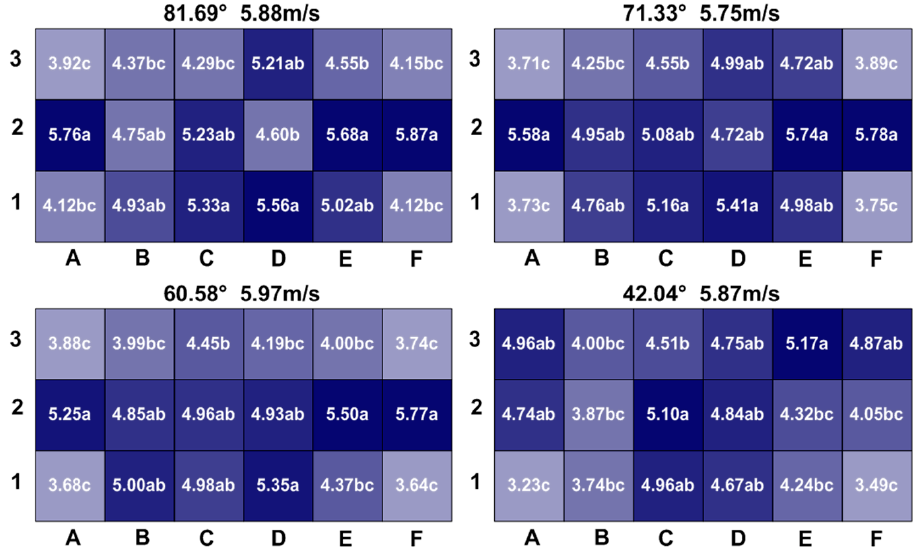
Figure 12. Spatial distribution of velocity of throughfall droplets. Different letters indicate significant difference between data in each treatment ( p < 0.05). Data directly above each subplot represent the landing angle and resultant velocity of sprinkler irrigation droplets when canopy is not present.